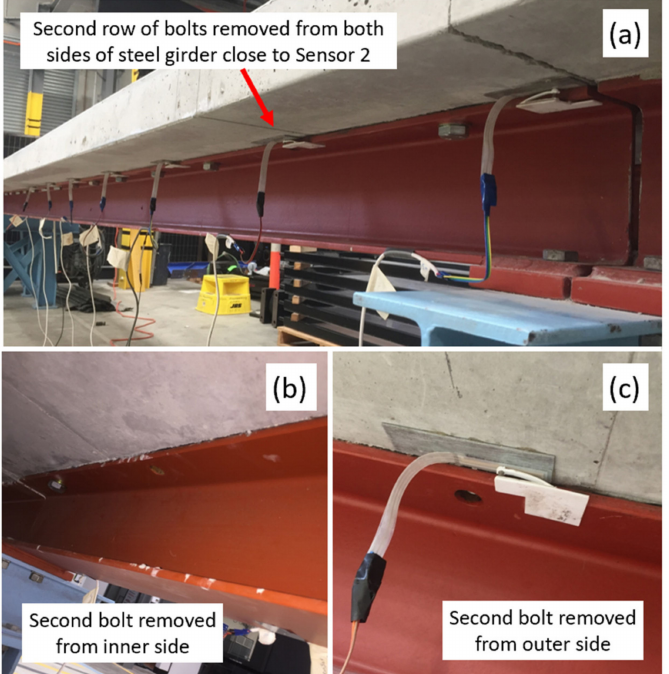
Figure 10. Second row of bolts are removed to simulate the damage at a single location; ( a ) The location of the damage near Sensor 2, ( b ) the removed bolt from the outer side and ( c ) the removed bolt from the inner